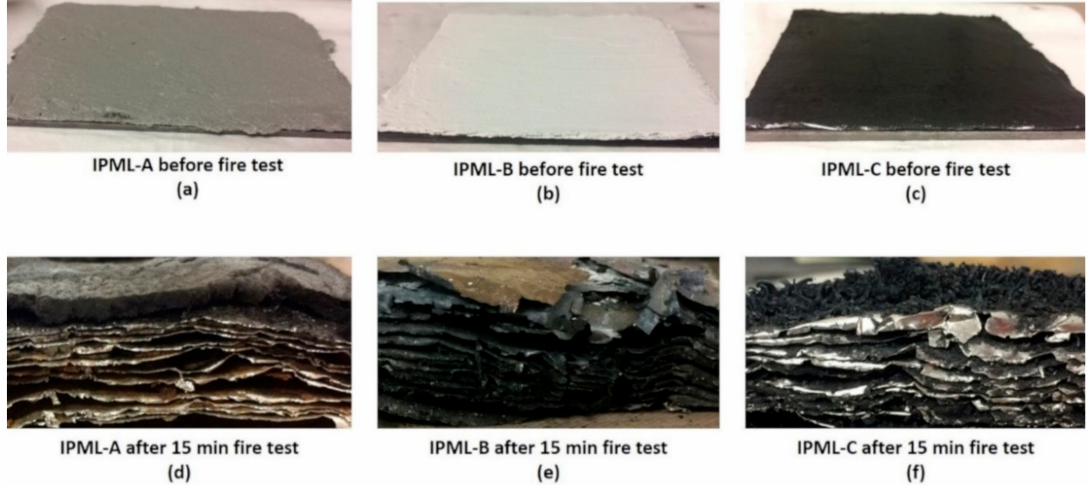
Figure 8. Cross-section of IPML after 15 min burn-through test exposition (( a ) IPML-A before fire test, ( b ) IPML-B before fire test, ( c ) IPML-C before fire test, ( d ) IPML-A after 15 min fire test, ( e ) IPML-B after 15 min fire test, and ( f ) IPML-C after 15 min fire